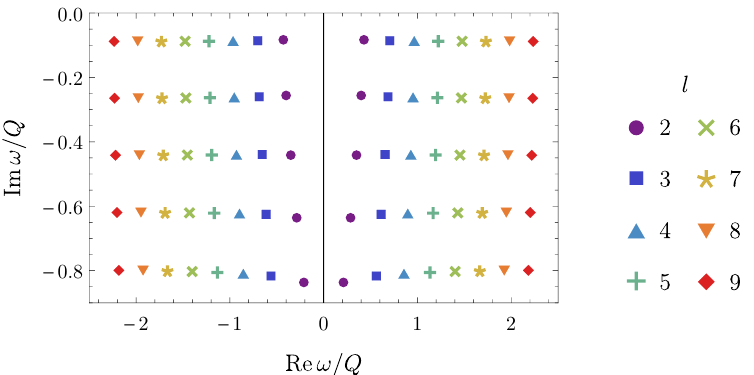
Figure 5. QNM frequencies of metric perturbations of the (3 + 1) -dimensional asymptotically flat extremal Reissner-Nordström black hole, in units of the black hole charge Q , computed using the third-order WKB approximation of refs.